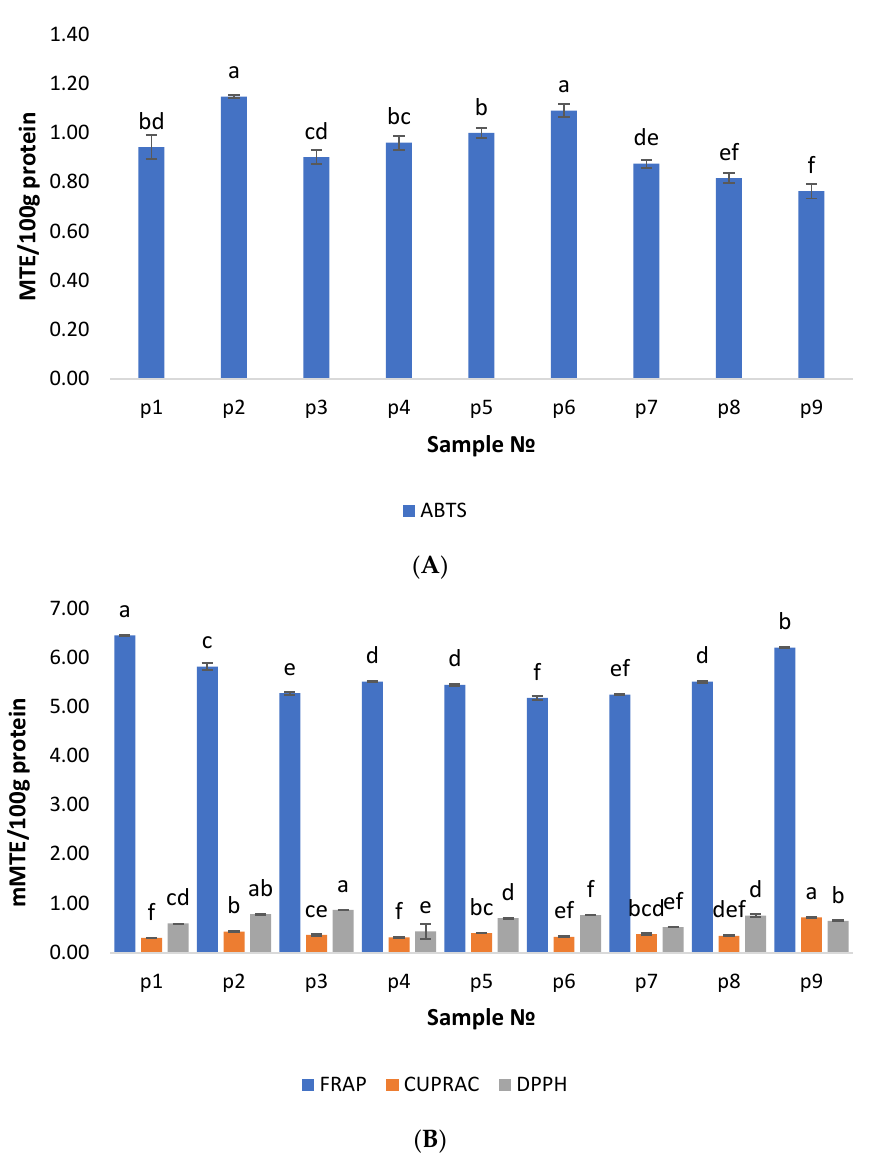
Figure 1. Antioxidant activity of lupin protein hydrolysates according to ( A ) ABTS, and ( B ) DPPH, FRAP, and CUPRAC. Values are means ± SEM, n = 3 per treatment group. Different letters (a–f) within each assay chart columns indicate significant differences ( p < 0.05) between treatments as analyzed by one-way ANOVA and TUKEY test.